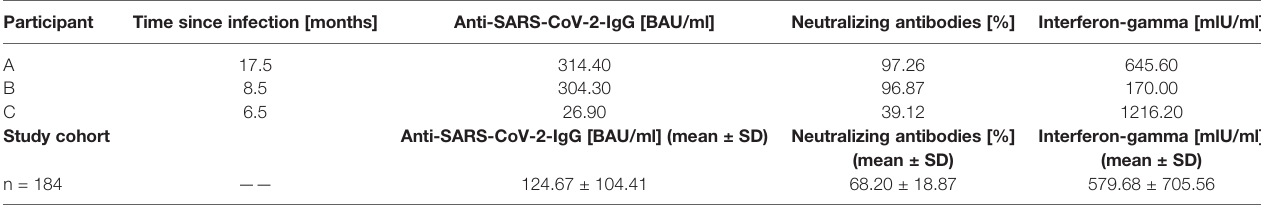
TABLE 1 | Immune status of previously infected and vaccinated participants in comparison to the mean values of the study